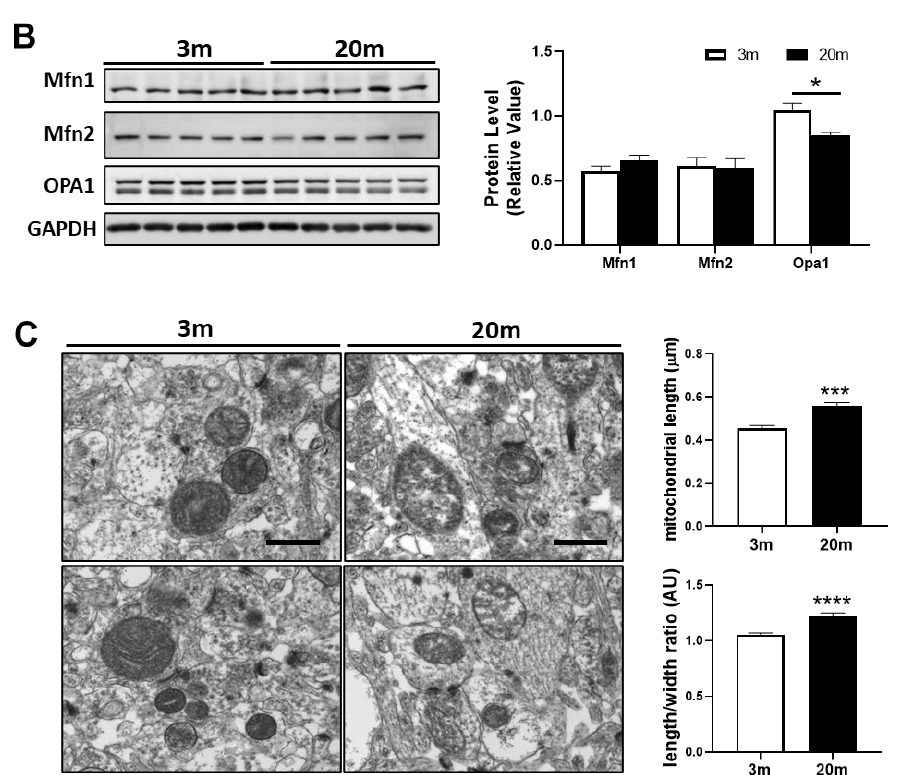
Figure 4. Changes in proteins implicated in mitochondrial fission and fusion processes in the hippocampus of aged female C57BL/6J mice. ( A ) Western blot of hippocampal lysates of 3 mo and 20 mo old mice, with their densitometric analysis of proteins involved in mitochondrial fission, including Drp1, pDrp1 S616, pDrp1 S637, and mitochondrial fission factor (MFF). ( B ) Western Blot of the protein involved in mitochondrial fusion, including Mfn1, Mfn2, and OPA1. ( C ) Representative TEM images and analysis showing mitochondrial length and mitochondrial AR in both 3 mo and 20 mo mice (26,500×). The scale bar corresponds to 500 nm. Densitometric analysis is expressed as levels relative to control. Graph bars represent means ± SEM. * p < 0.05, *** p < 0.005, **** p < 0.001.